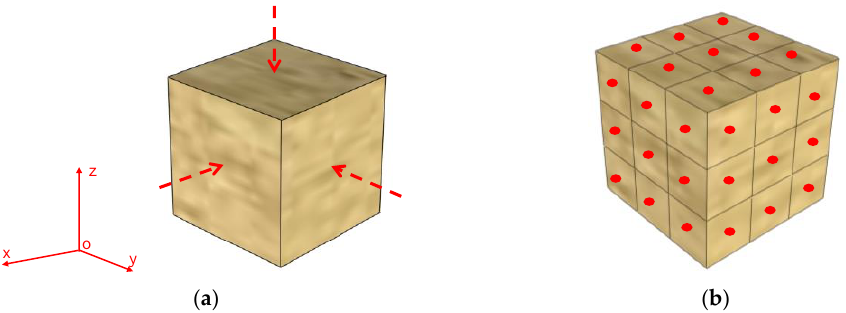
Figure 6. Schematic diagram of the weathering index test. ( a ) Schematic diagram of wave velocity test, the arrows indicate the three test directions; ( b ) hardness test points , the circles indicate the different test areas. Table 2. Average value list of some physical indexes of yellow sandstone.